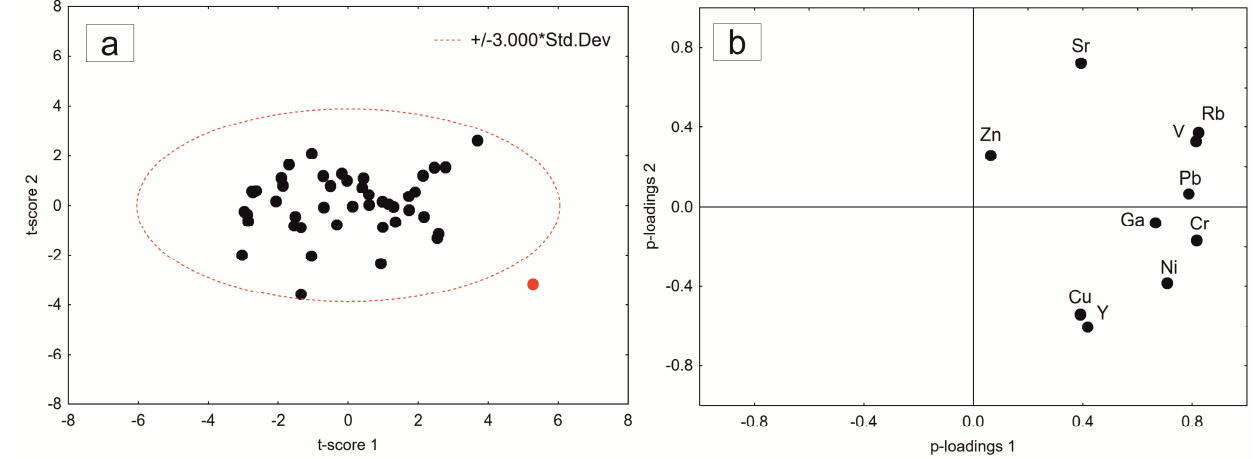
Figure 6. Score (t1–t2) ( a ) and loading (p1–p2) ( b ) plots in the space of principal components.